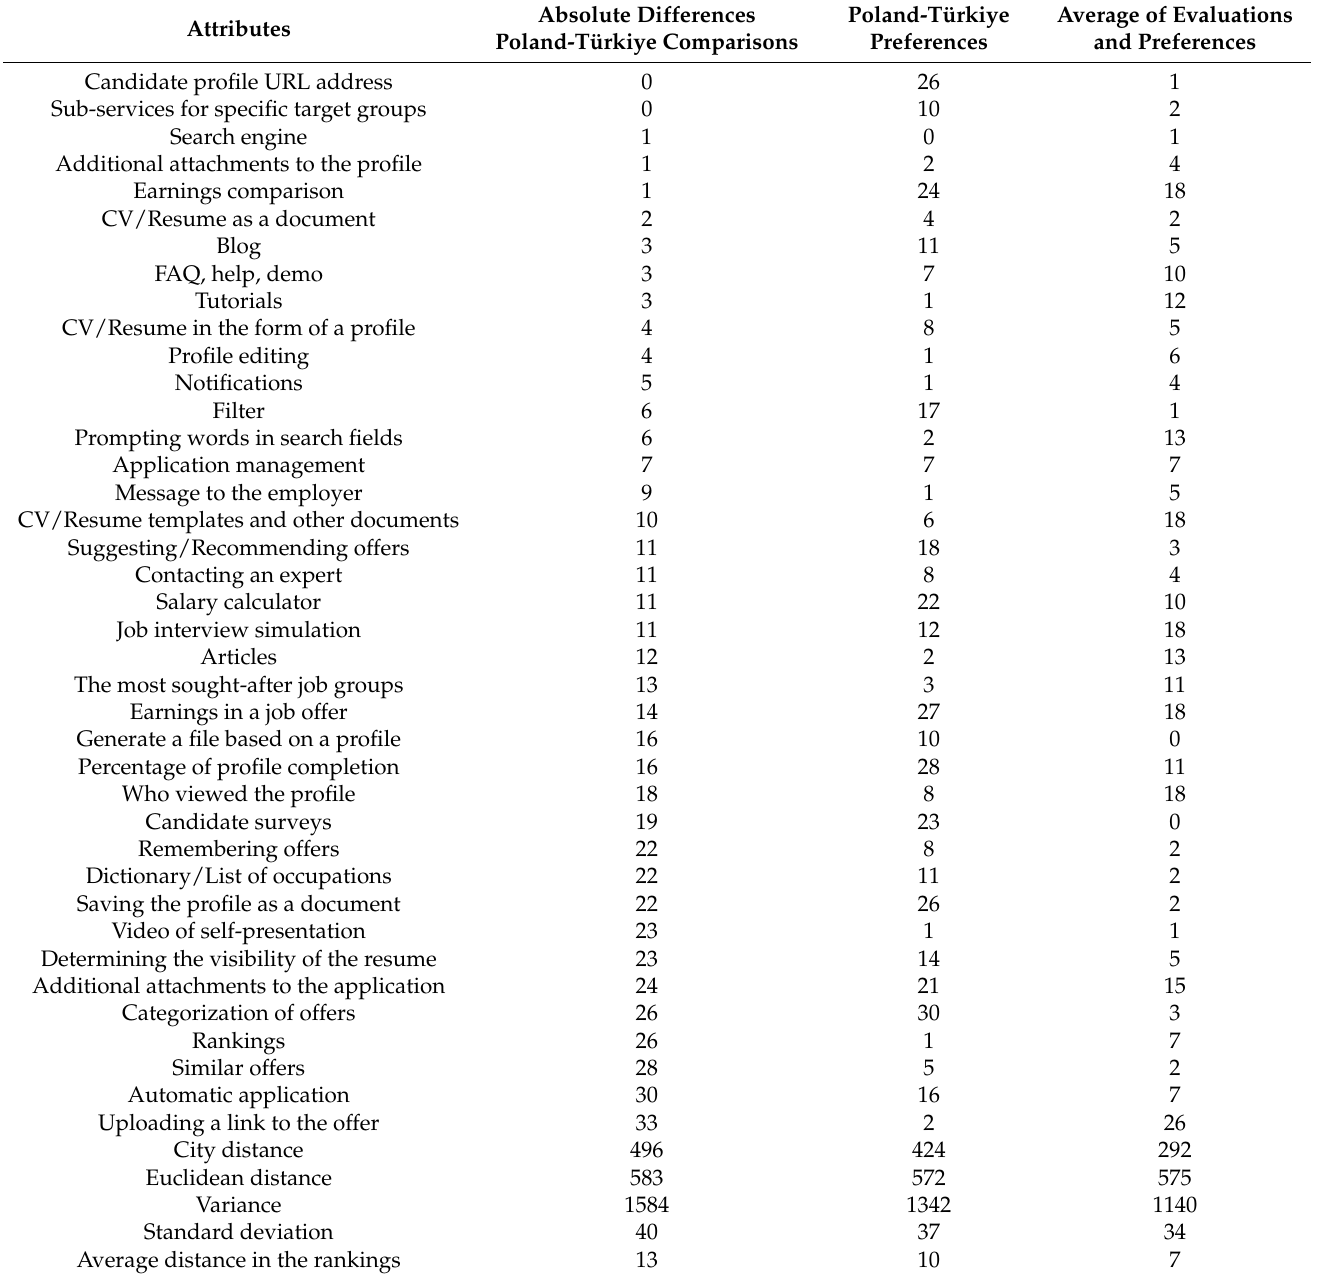
Table 5. Differences in attribute ratings obtained from analysis of actual HRM portals, differences in user preferences, and differences between average ratings and average preferences in Poland and